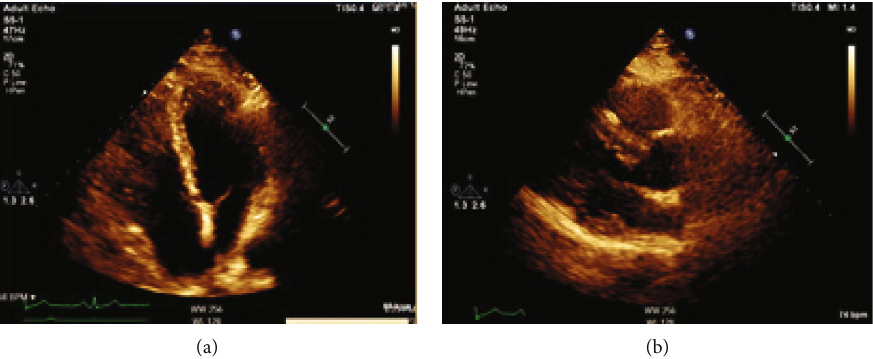
Figure 7: (a) Selected image of transthoracic echocardiogram in apical 4 chamber view and (b) a parasternal long axis view showing marked interval improvement of the pericardial thickening with resolution of the pericardial e ff usion.